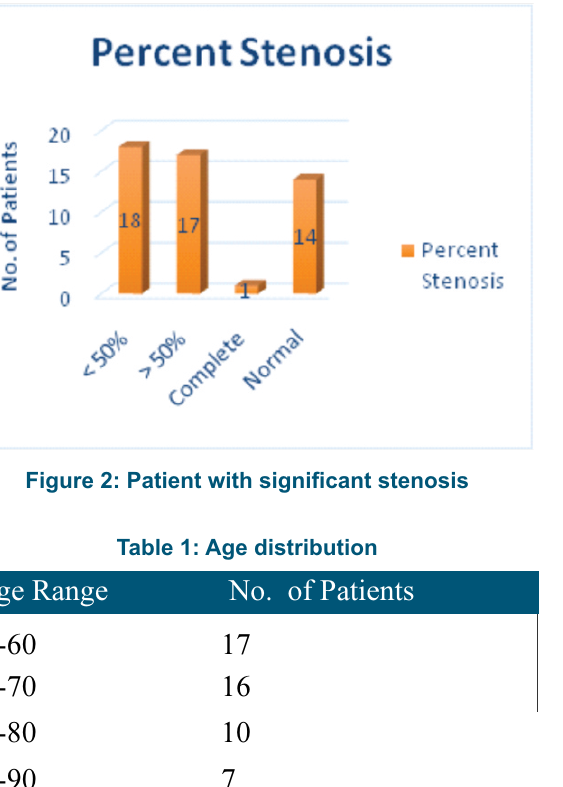
Figure 5: Plaque characterization